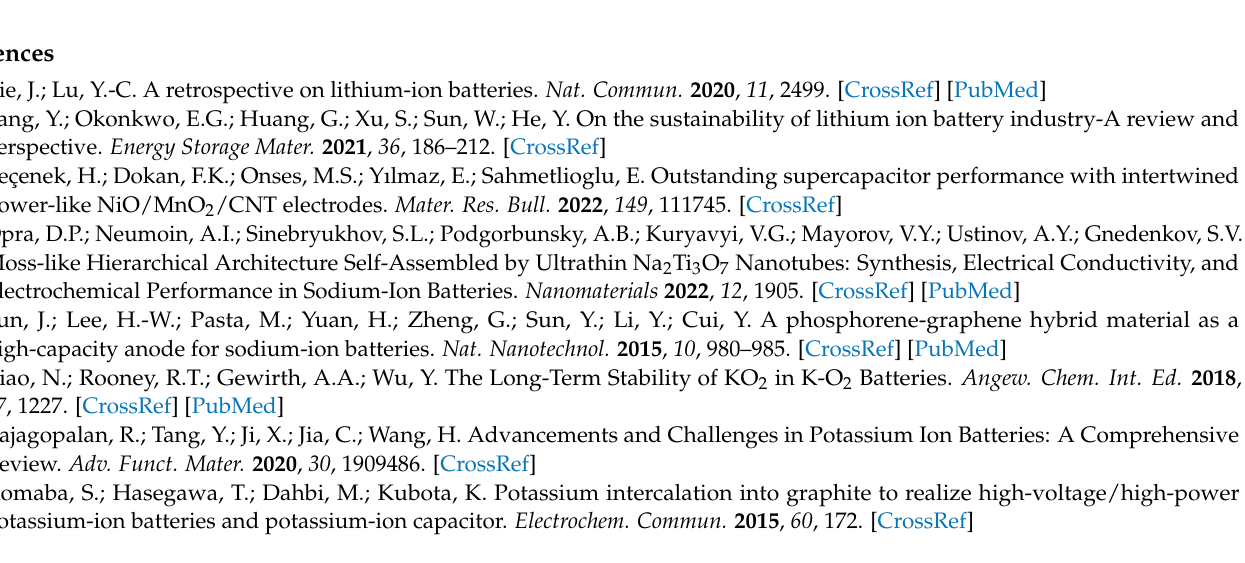
Figure S2: XRD pattern of SHC; Figure S3: (a) The initial charge-discharge profiles of SHC. And (b) Charge-discharge profiles of SHC at various cycles; Figure S4: EIS Nyquist plots of (a) SHC and (b) N-SHC after various cycles; Figure S5: (a) The initial CV curves of SHC at the scan rate of 0.1 mV s − 1 . (b) CV curves of SHC at scan rates from 0.2 to 1 mV s − 1 , corresponding (c) Relationship between log (peak current) versus log (scan rate) and (d) calculated normalized percentages of capacitive capacities contribution at various scan rates; Figure S6: The detailed GITT profiles of N-SHC; Figure S7: The GITT profiles of SHC; Table S1 Comparison of the electrochemical performance of N-doping hard carbons. References [45–48] are cited in the supplementary